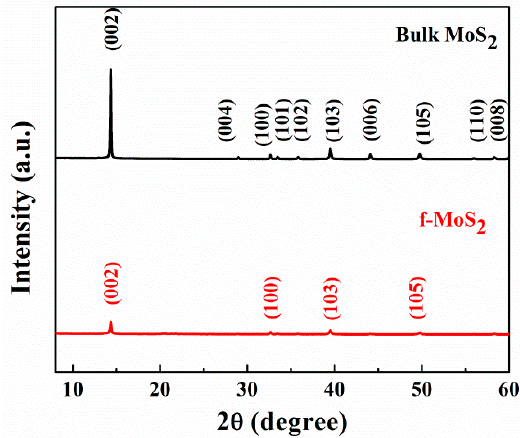
Figure 5. XRD spectra of bulk MoS 2 and exfoliated f-MoS 2 nanoplatelets.